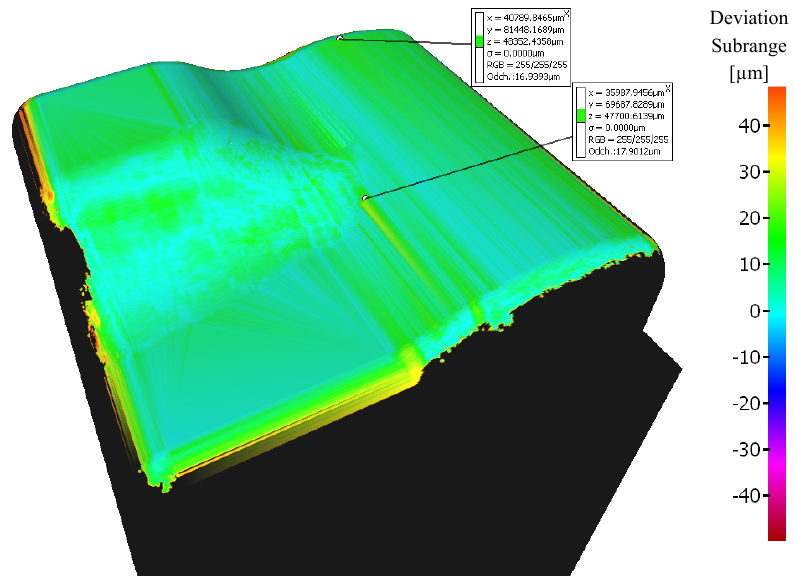
Figure 13. Comparison of the initial model with the workpiece after 5-axis milling (tool inclination β f = 0°, β n = 10°).